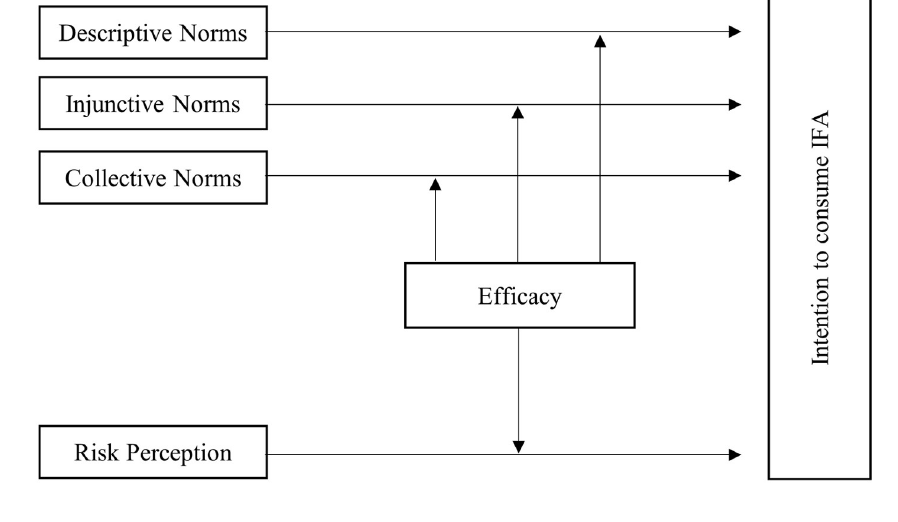
Fig 1. Conceptual model. This figure depicts the proposed conceptual model-an integration of TNSB and RPA in which efficacy acts as a moderator to the normative predictors outlined in TNSB and risk